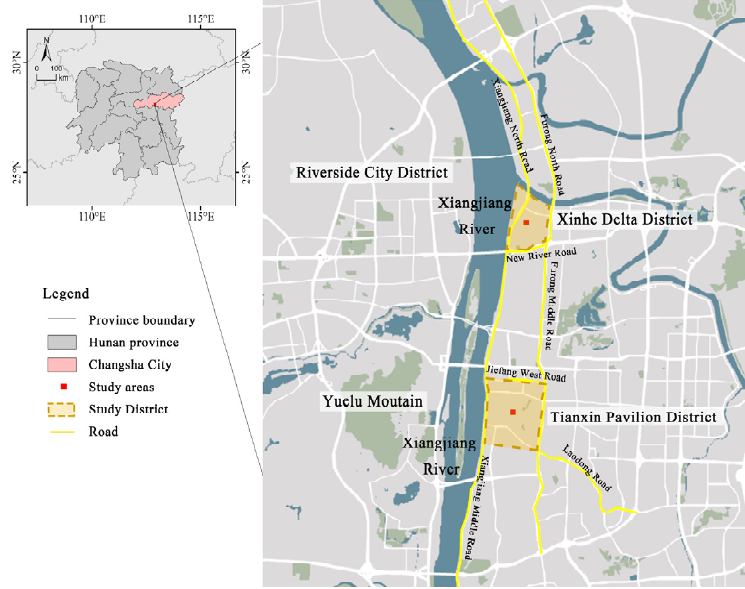
Figure 8. Regional location map of the sample districts.